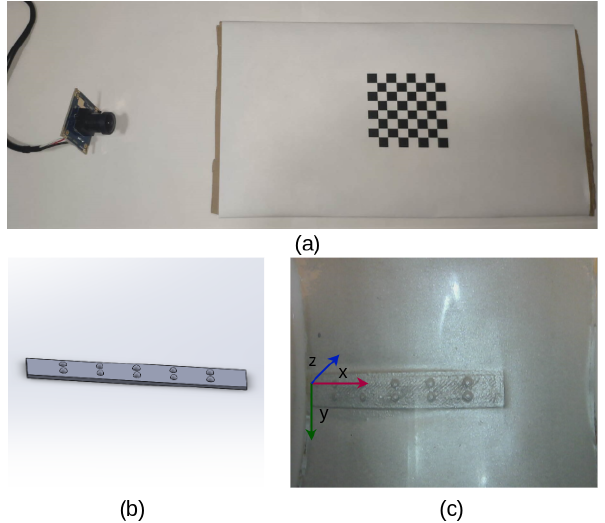
Figure 4. The calibration of the TouchRoller sensor. ( a ) A 7 × 7 chessboard was used to calculate the intrinsic matrix of the camera. ( b ) A 3D-printed solid with an array of 2 × 5 hemispheres was employed to estimate R and t . ( c ) The corresponding tactile image when the sensor presses on the 3D-printed solid shown in ( b